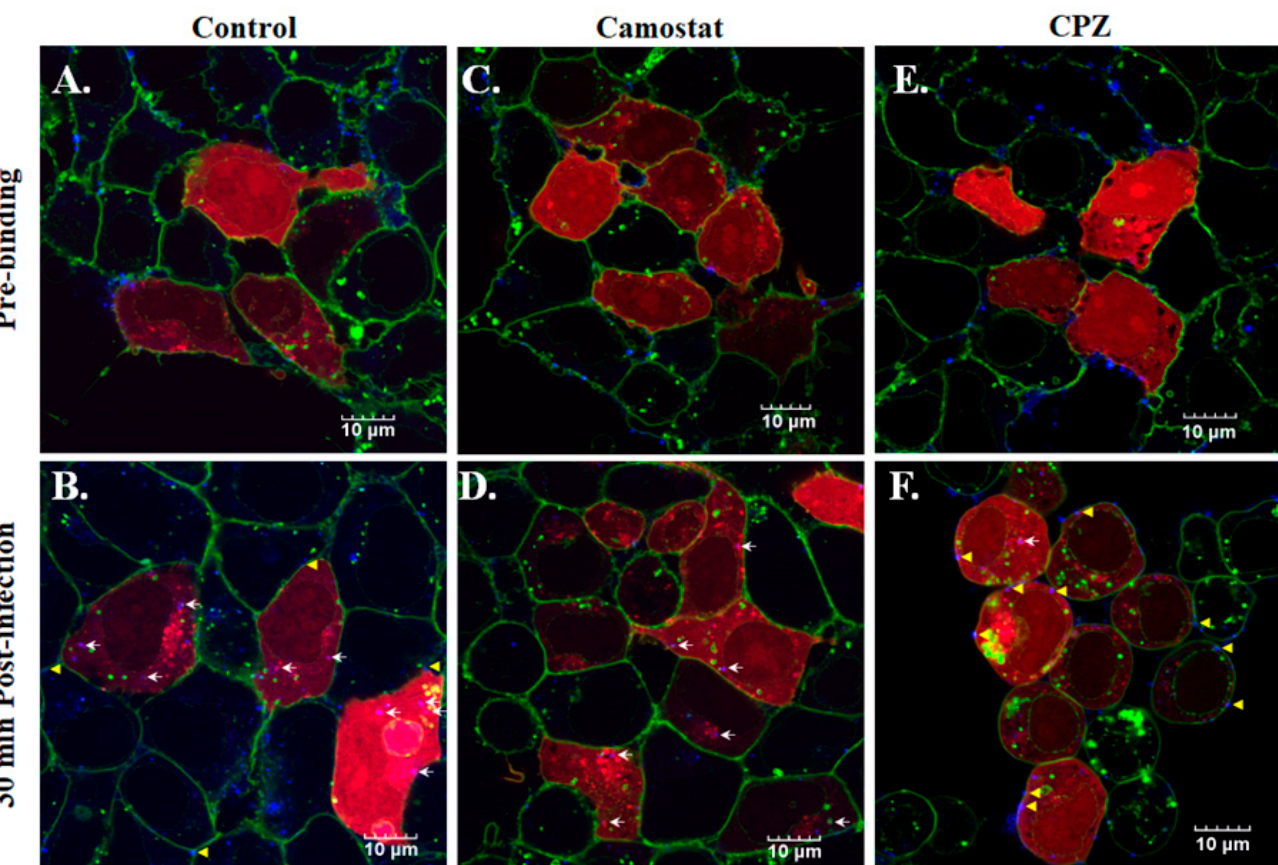
Figure 7. The effects of various inhibitors on SCoV2-SEM VLPs infection. Atto647N-tagged SCoV2-SEM VLPs infected HEK-293T-ACE2 ( A , B ), in the presence of either 100 μ M of Camostat, a pharmacological inhibitor of TMPRSS2 ( C , D ), or 50 μ M of CPZ, a clathrin-mediated endocytosis inhibitor ( E , F ). Cellular membrane stained with WGA488 was shown in green, mCherry-Rab5-indicated early endosome was shown in red, and Atto647N-tagged SCoV2-SEM VLPs were depicted in blue. The confocal merging images were acquired at the pre-binding step ( A , C , E ) and at 30 min post-infection ( B , D , F ). White arrows indicated the co-localization of SCoV2-SEM VLPs with early endosomes. Yellow arrows indicated the membrane fusion of SCoV2-SEM VLPs. Scale bar, 10 μ m.